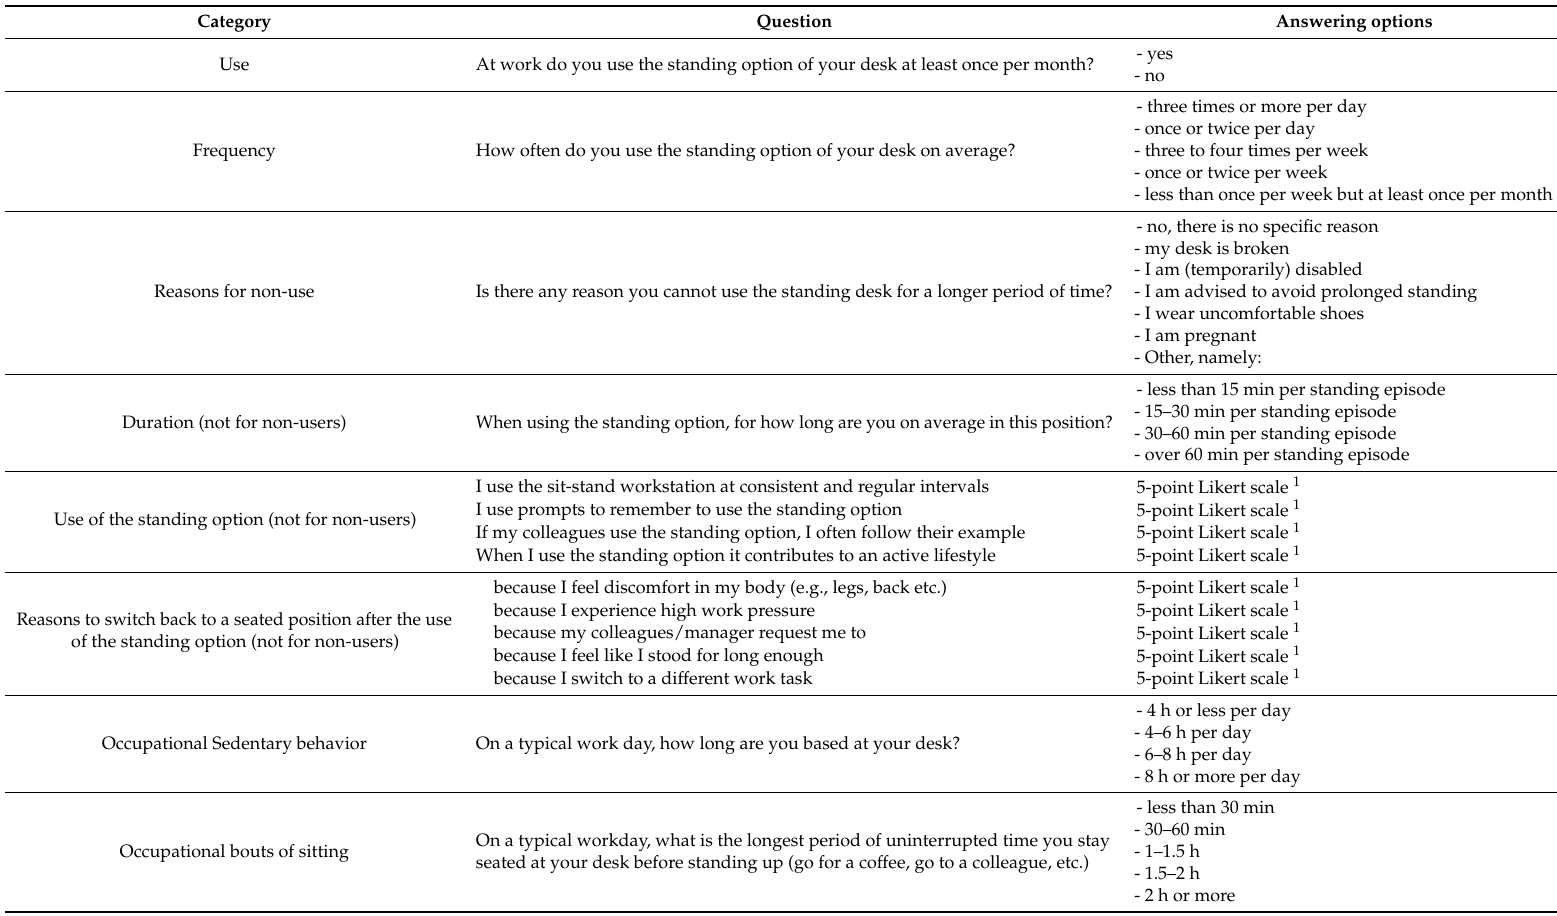
Table A1. Specific questions and answer categories on sedentary behaviour and use of the sit-stand